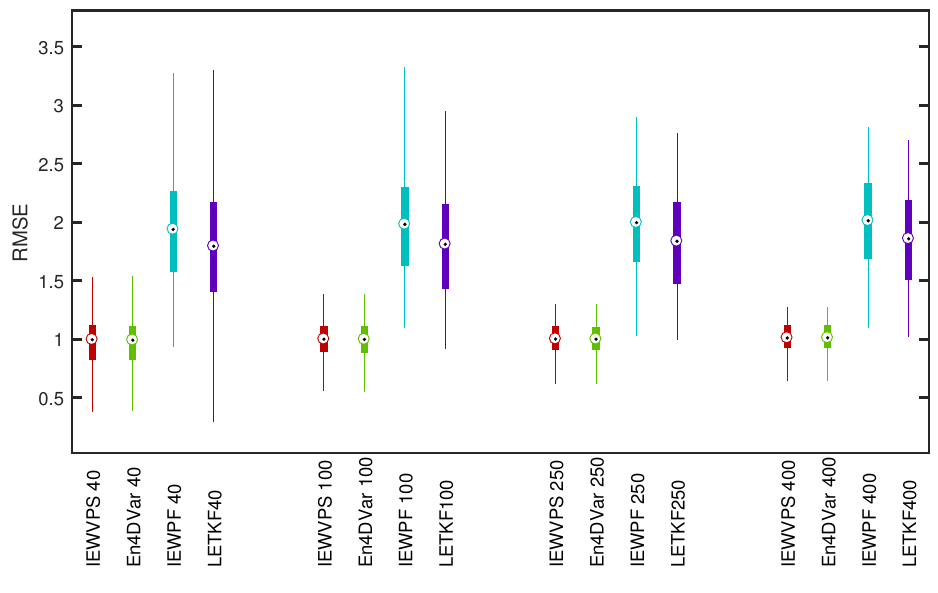
Figure 4. The averaged RMSE for the different model dimensions. Red for IEWVPS experiments; Green for En4DVar experiments; Cyan for IEWPF experiments; and Purple for LETKF; the edges of the bar represent the minimum and maximum value, the filled box in the bar represents 99.3% data, and the cycle in bar represents the median